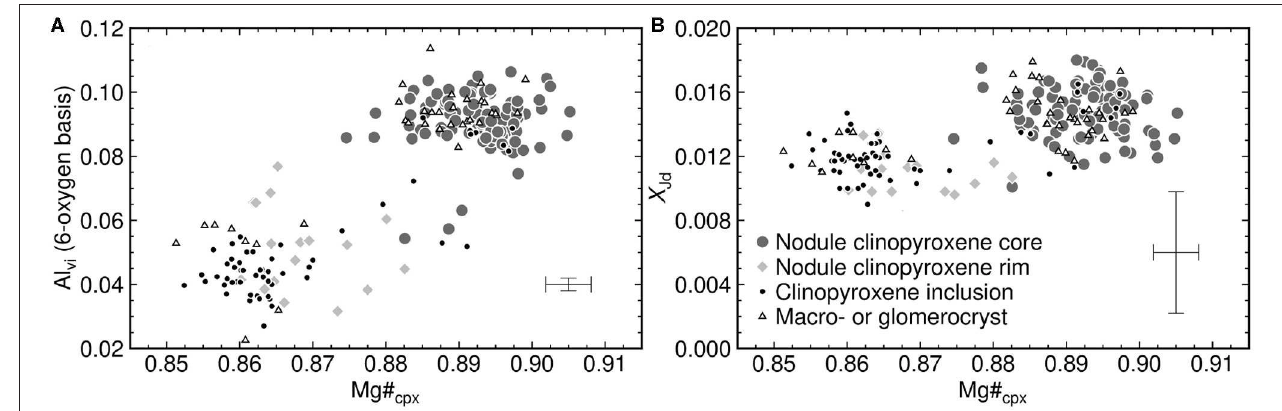
FIGURE 6 | Variations in pressure-sensitive clinopyroxene components in sample JM27 from the Borgarhraun lava flow in North Iceland. Analyses are divided into four textural associations: nodule cores, nodule rims, inclusions and macrocrysts or glomerocrysts. 2 σ analytical uncertainties based on repeat measurements of the Ney County Cr-Augite (NMNH 164905) are shown (Jarosewich et al., 1987). (A) Plot of Mg# cpx [where Mg# cpx six-oxygen basis. (B) Plot of Mg# cpx vs. jadeite component ( X Jd ) content calculated following Putirka